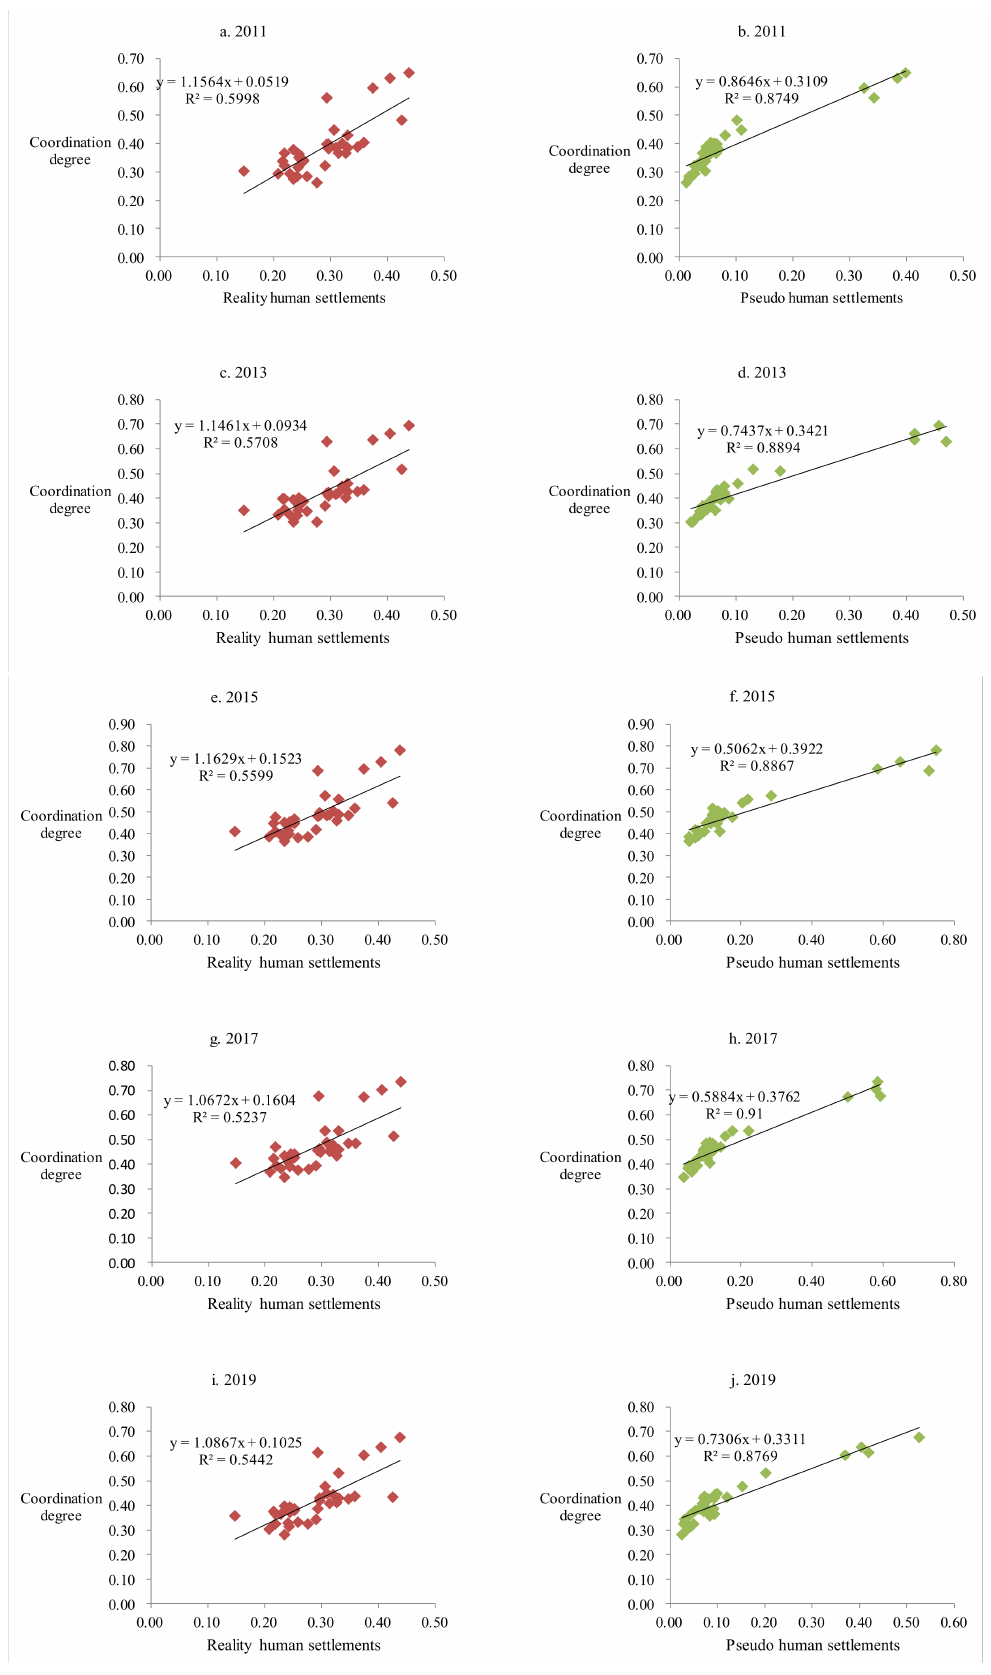
Figure 9. The trend line of urban PHSs and RHSs with coordination in northeast China in